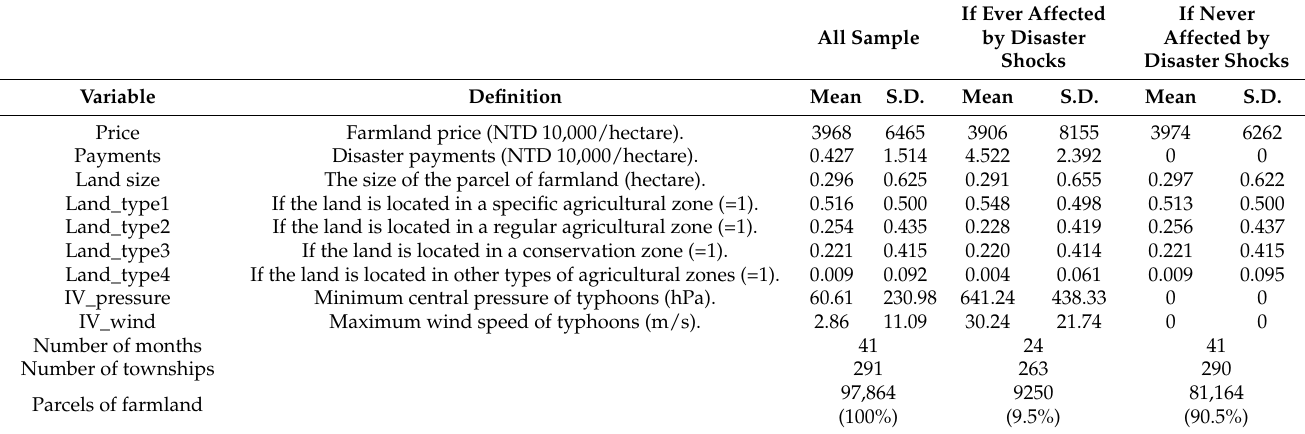
Table 2. Distribution of agricultural disaster payments in the township